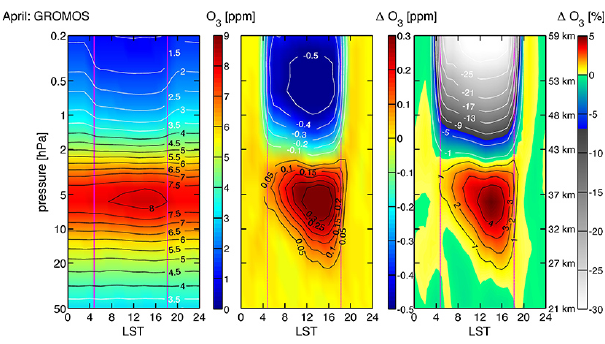
Figure 4b. Same as Fig. 4a but for the month of